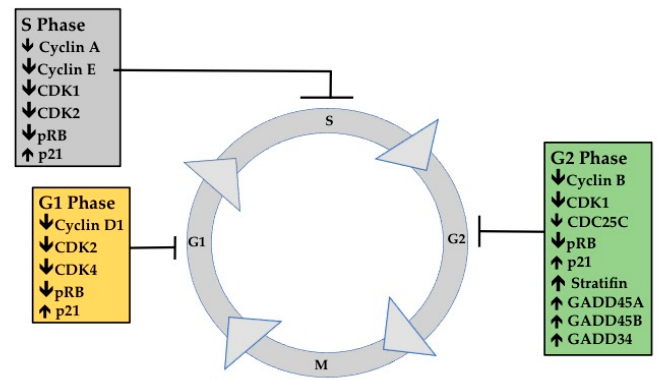
Figure 1. Schematic illustrating the pleiotropic effects of docosahexaenoic acid (DHA) on genes and proteins throughout the cell cycle in various cancer cell types (referenced in accompanying Table 1).